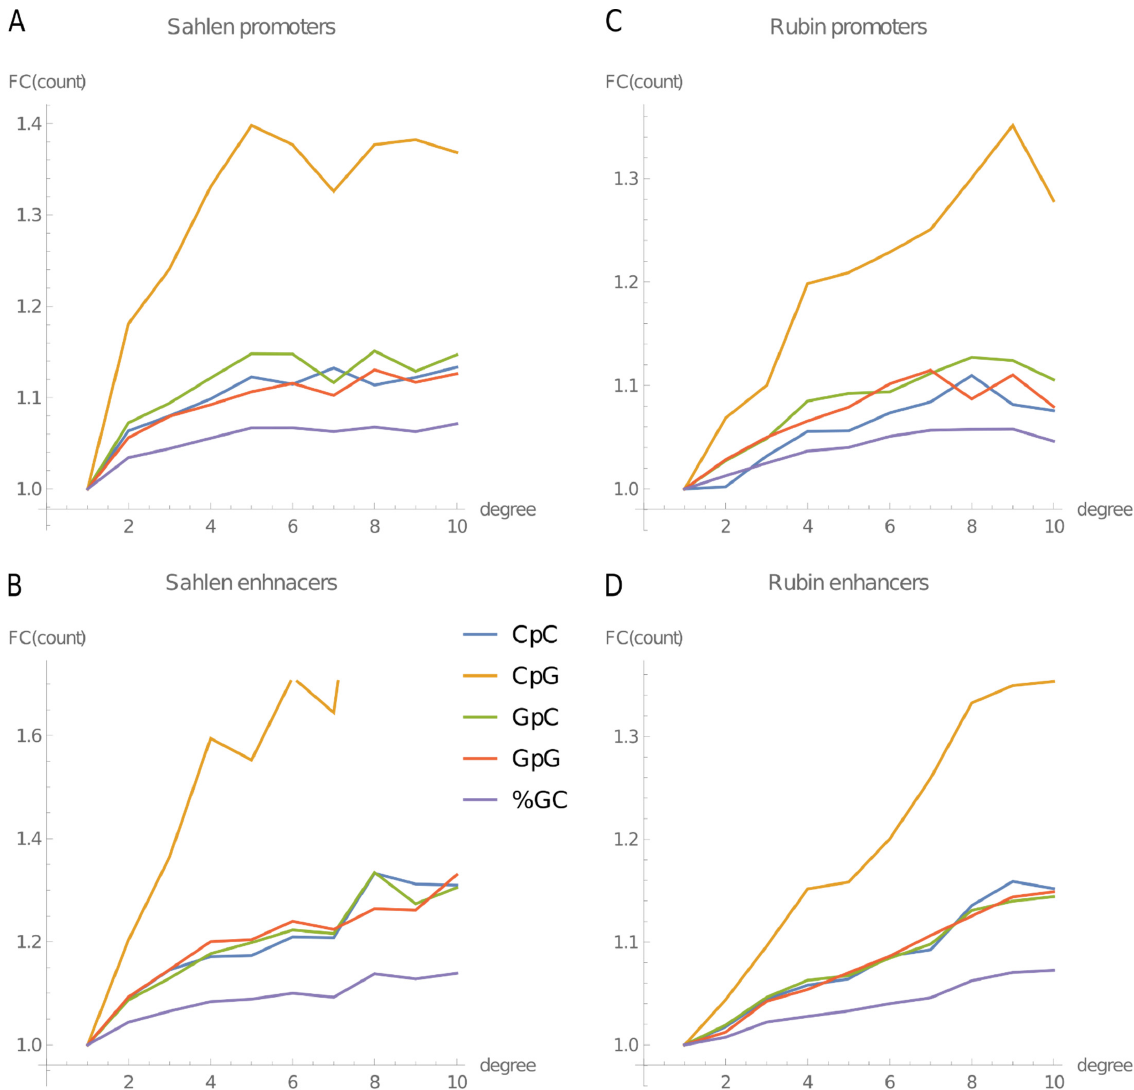
Figure 6. Relative changes of the average GC content (%GC) and of the average counts of the four dinucleotides of G or C in promoters and enhancers as the function of their node degree. FC—the fold change relative to the degree 1. ( A , B ) Data from the mouse ES cells. ( C , D ) Data from the human keratinocytes. ( A , C ) Promoters. ( B , D ) Enhancers. The correlations between the GC content or (G or C)-dinucleotide counts and node degree are all positive and highly significant (Table 1), confirming that the relationship between the GC content and the node degree holds not only for the mouse ES cells but also for differentiated cells (keratinocytes) in human. The differences in the counts of the four dinucleotides of G or C with the node increasing from 1 to 10 degree were all simi- lar (Figure S4), but CpGs had the lowest counts of the four (Figure S5), resulting in the highest relative change.